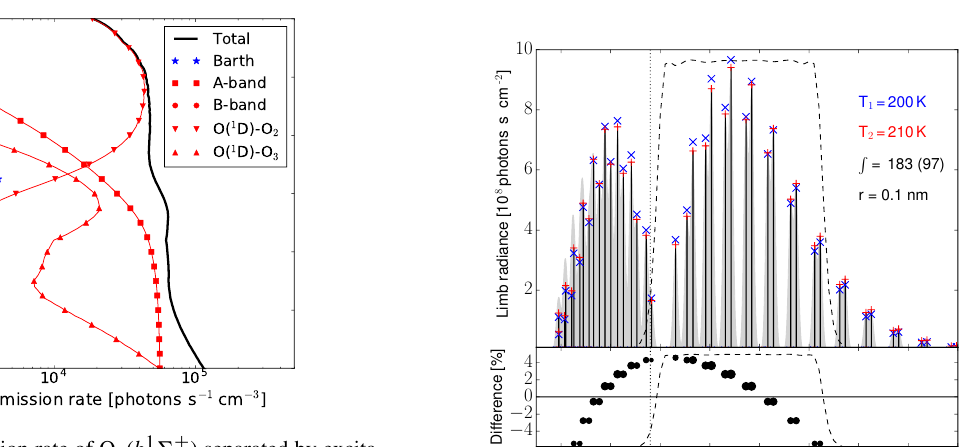
Figure 1. Volume emission rate of O 2 ( b 1 (cid:54) + g ) separated by excita- tion processes. “Barth” indicates the emission rates created by the recombination of atomic oxygen. This is the only excitation process being active during day and night. “A-band” and “B-band” label the fraction of emissions excited by resonance absorption in those bands. “O 2 ” and “O 3 ” mark the excitation by collisions with O( 1 D), which is created by photolysis of O 2 and O 3 , respectively.